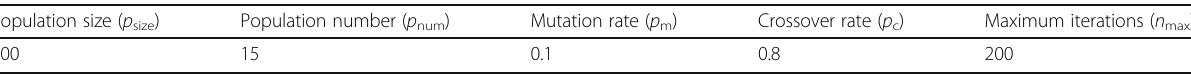
Table 5 The parameters of genetic algorithm